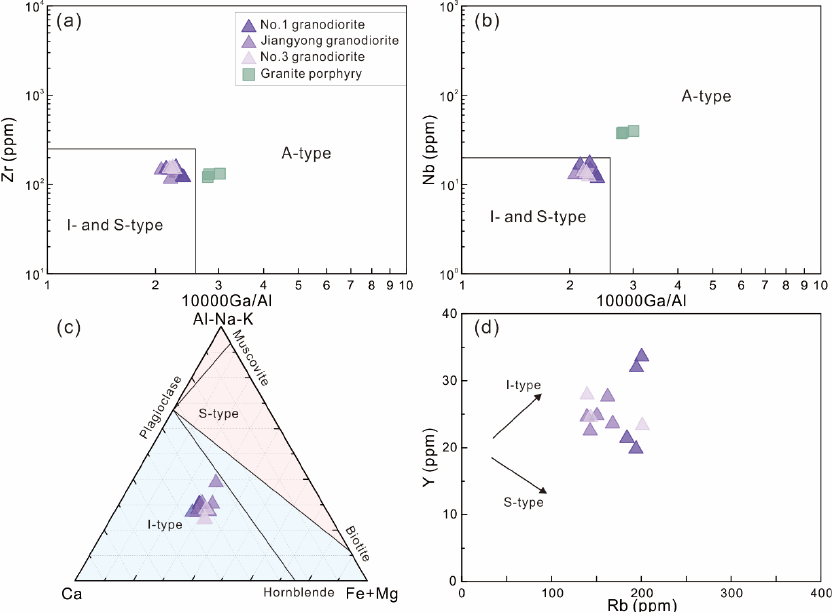
Figure 10. Petrogenetic discrimination diagrams of the studied granitoids: ( a ) 10,000 Ga/Al vs. Zr; ( b ) 10,000 Ga/Al vs. Nb; ( c ) Al–Na–K–Ca–Fe+Mg; ( d ) Rb vs. Y. ( a , b ) are after [63]; ( c ) is after [64]; and ( d ) is after [65].